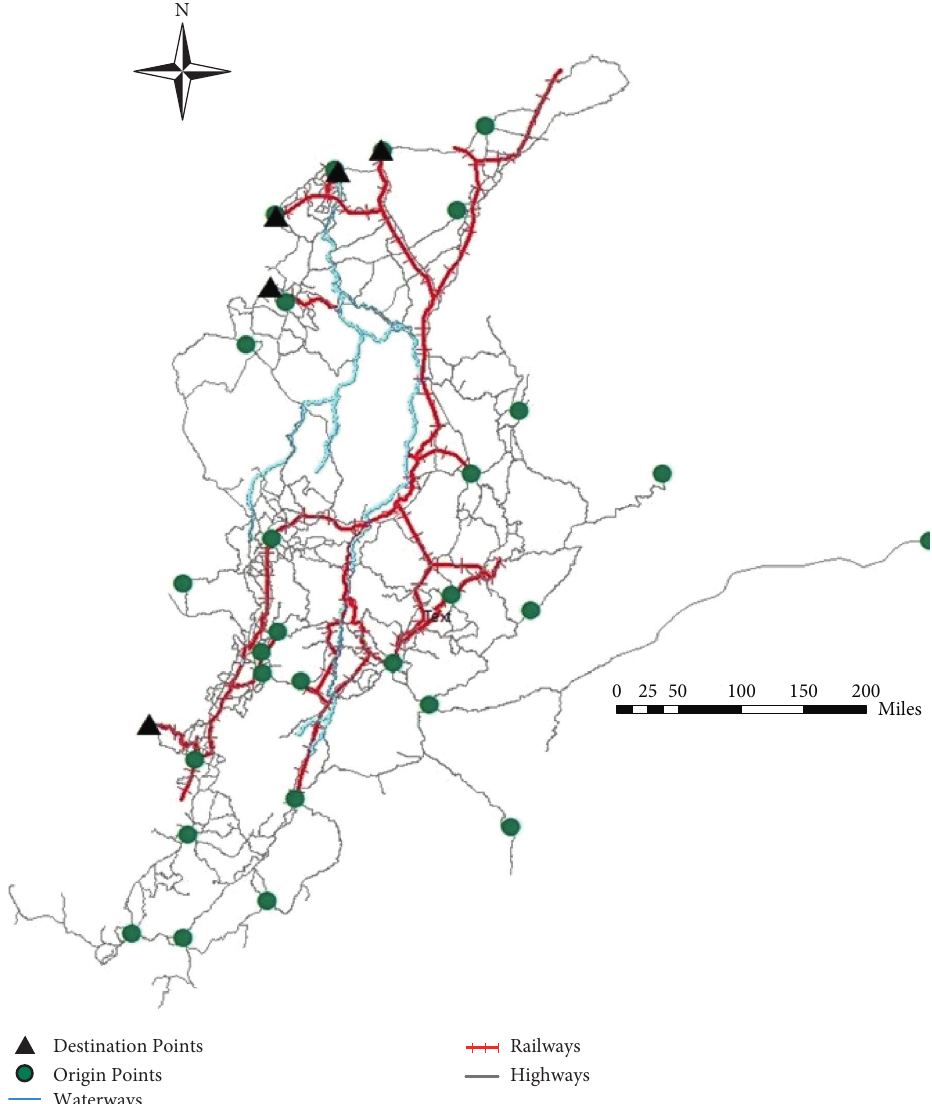
Figure 2: Origin-destination points and transport